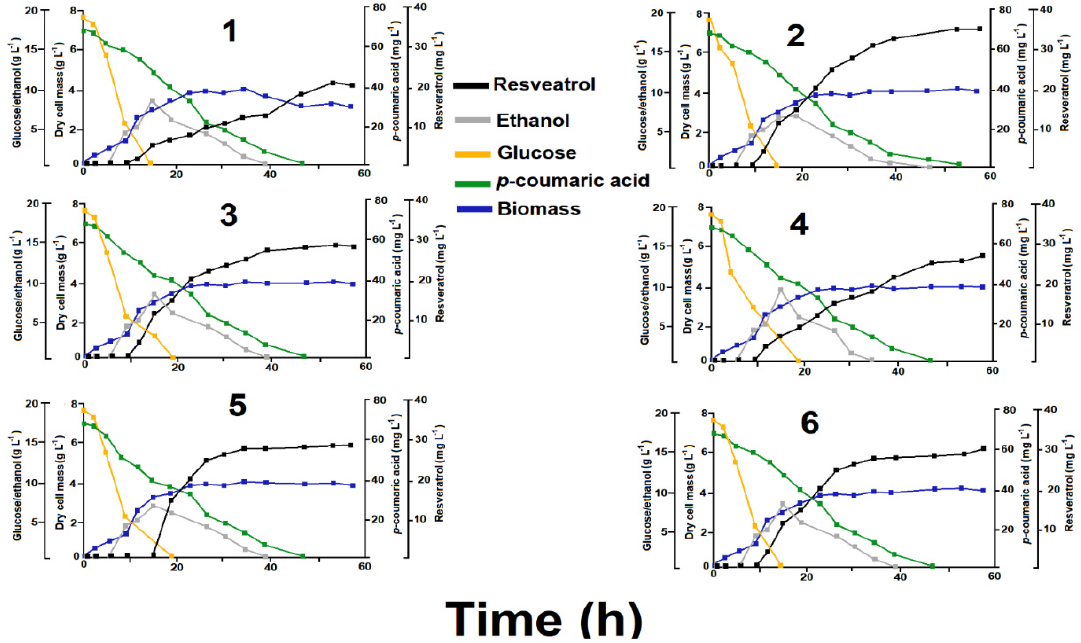
Figure 4. Changes in the levels of glucose, ethanol, p -coumaric acid, resveratrol and dry cell mass under fermented batch conditions. Kinetics for the yeast lines pESC-Pa4CL1-PhStS ( 1 ), pESC-Pa4CL1-PcPKS5 ( 2 ), pESC-Pa4CL1-MaSTS3 ( 3 ), pESC-Pa4CL1-RtSTS ( 4 ), pESC-Pa4CL1-VvVST1 ( 5 ), pESC-Pa4CL1-AhSTS ( 6 ).